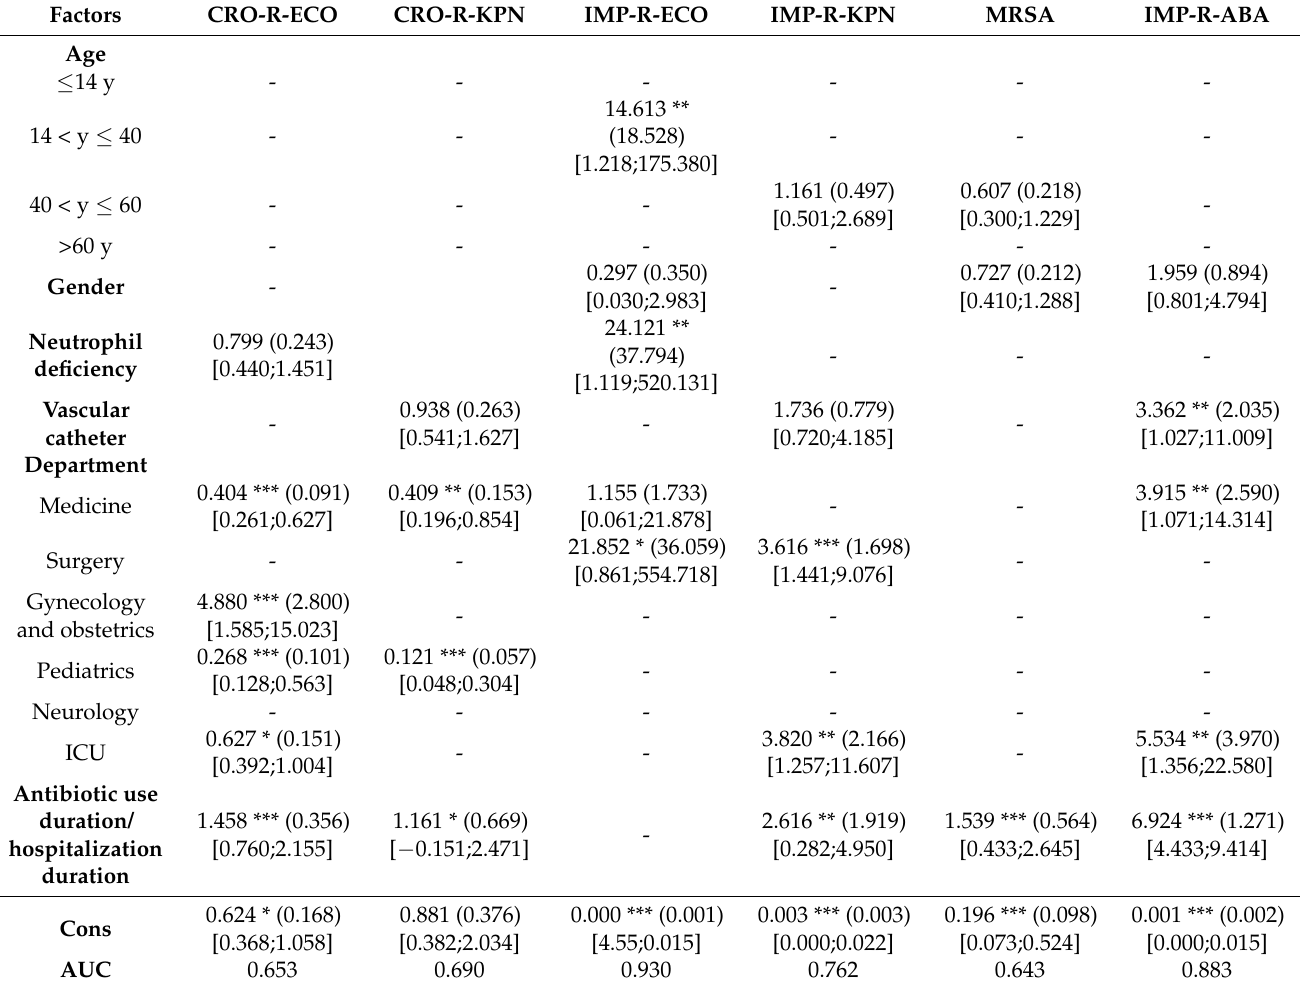
Table 4. Results of logit model analysis for bacterial bloodstream